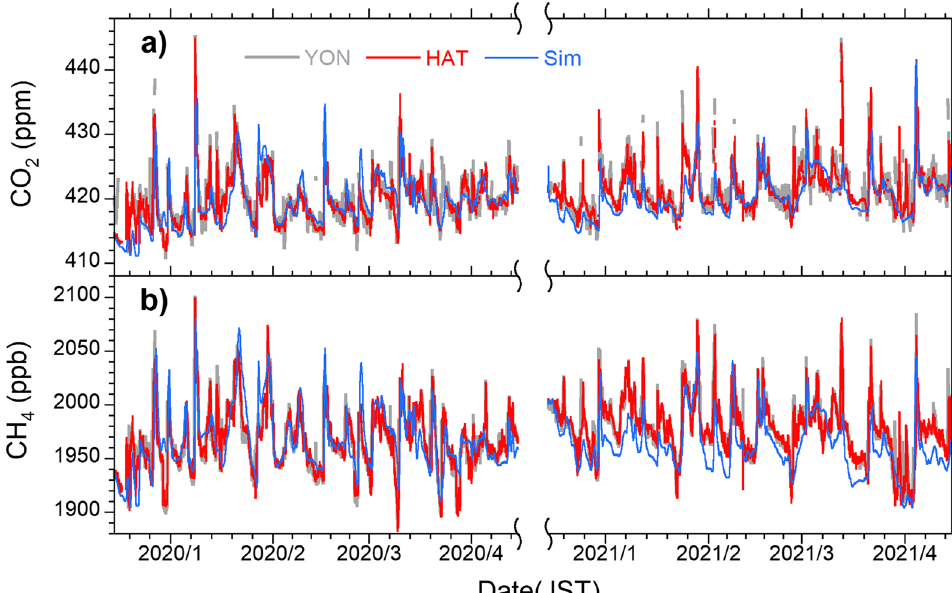
Fig. 2 Time series of ( a ) atmospheric CO 2 and ( b ) CH 4 hourly mole fractions. The data obtained at YON (gray lines) and HAT (red lines) during the periods from December 15, 2019, to April 15, 2020, and from December 15, 2020, to April 15, 2021, are depicted. The simulated CO 2 and CH 4 for HAT are plotted as blue lines (see